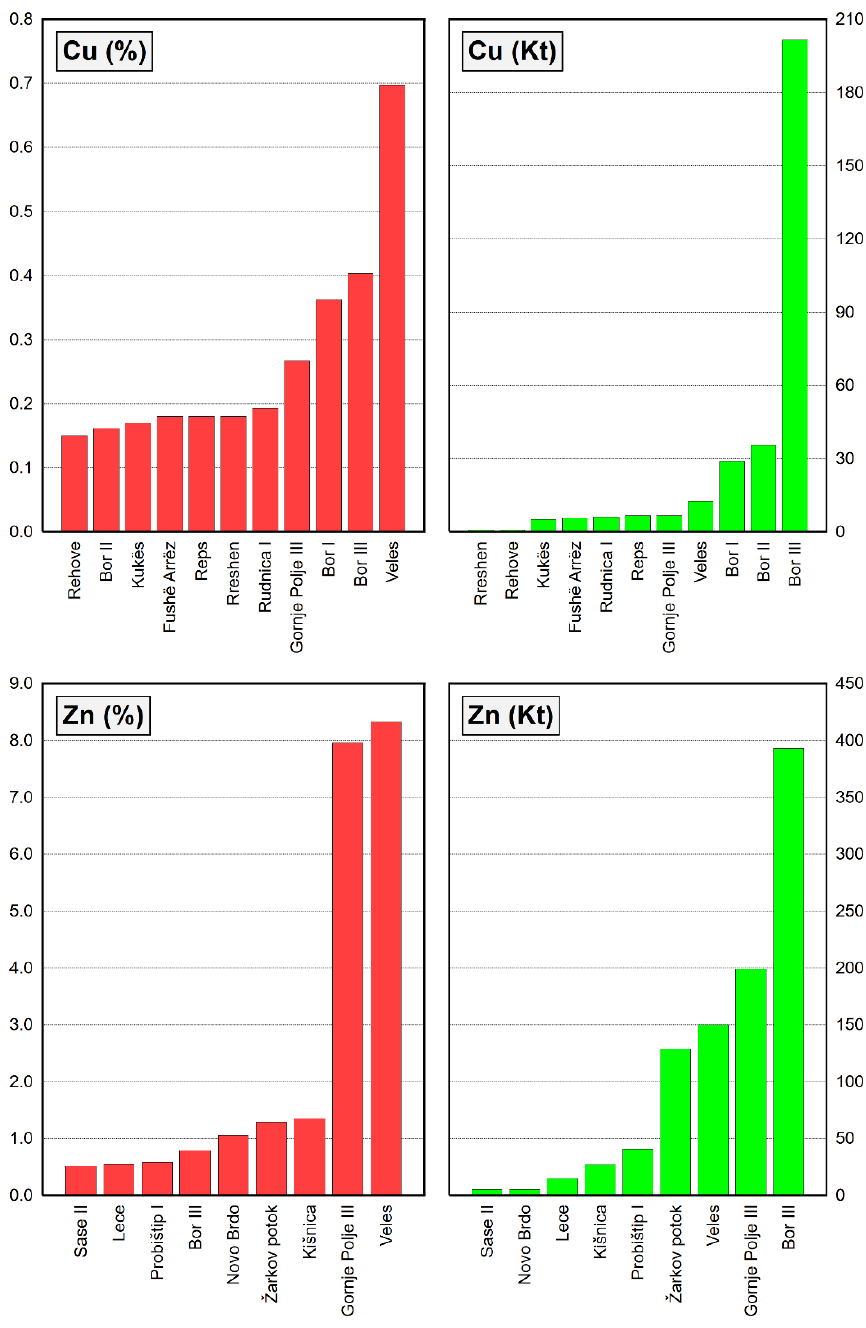
Figure 5. Contents and quantities of Cu and Zn in prospective landfills.